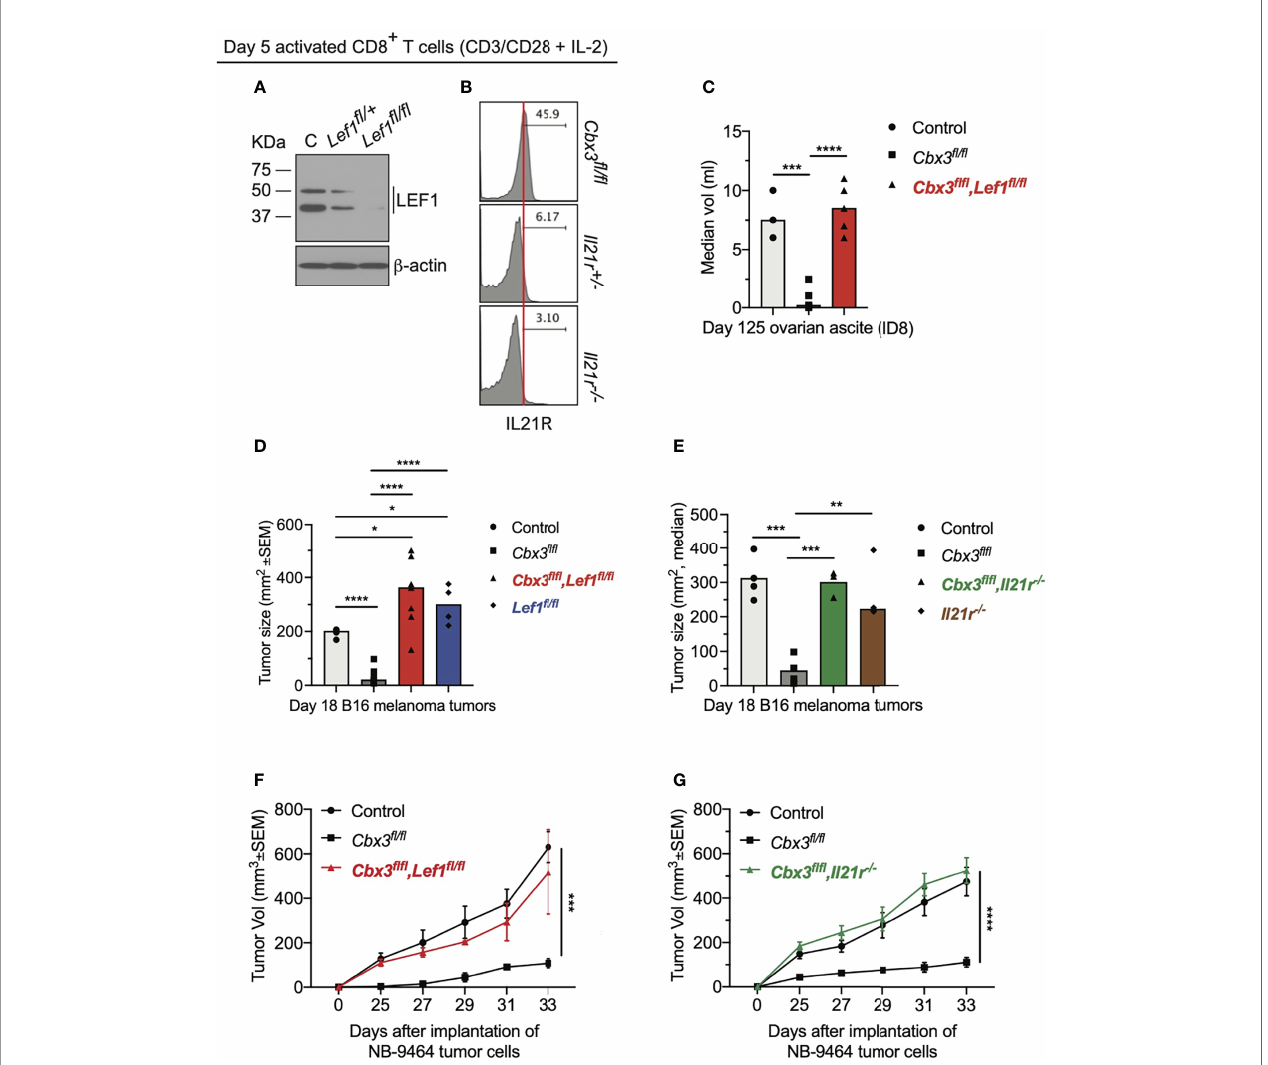
FIGURE 5 | LEF-1 and IL-21R are indispensable for halting tumor growth. (A) Western blot of LEF-1 expression was done using total protein lysates of day 5 activated/ differentiated CD8 + T cells; C: Cbx3 /HP1 g -de fi cient; Lef1 fl /+ and Lef1 fl / fl : Cbx3 - Lef1 -de fi cient; representative of 4 experiments. (B) IL-21R expression was measured by fl ow; Cbx3 fl / fl : Cbx3 /HP1 g -de fi cient; Il21r +/- and Il21r -/- : Cbx3 - Il21r -de fi cient; representative of 4 experiments. (C) Ovarian ascites were measured on day 125 after tumor injection; bars: group median; Graphpad unpaired student t-test: ***p ≤ 0.001, ****p ≤ 0.0001; each symbol = one mouse; n = 3-5; Cbx3 fl / fl Lef1 fl / fl : Cbx3 - Lef1 -de fi cient; representative of 2 experiments. (D) B16 melanoma tumor burden was determined on day 18 after tumor injection; bars: group median; Graphpad unpaired student t-test: *p ≤ 0.05, ****p ≤ 0.0001; each symbol = mouse; for each genotype n = 4-7; Lef1 fl / fl : Lef1 ablation alone using CD8 a -Cre mice; representative of 3 experiments. (E) On day 10 after injection of tumor cells, tumor bearing B6SJ/L mice (CD45.1 + ) were treated with in vitro -activated/differentiated CD8 + T cells (CD45.2 + ) from control, Cbx3 fl / fl , Cbx3 fl / fl , Il21r -/- ( Cbx3 - Il21r -de fi cient) or Il-21r -/- (germline deleted) mice; **p ≤ 0.01, ***p ≤ 0.001; n = 3-4 recipients; representative of 2 experiments. (F) NBL tumor burden was determined starting on day 25 after injection of tumor cells then every 2 days until day 33; Graphpad two-way ANOVA: ***p ≤ 0.001; n = 2-5; representative of 2 experiments. (G) On day 14 after NBL injection, tumor bearing B6SJ/L mice were treated with in vitro -activated/differentiated CD8 + T cells from control, Cbx3 fl / fl or Cbx3 fl / fl , Il21r -/- ( Cbx3 - Il21r - de fi cient) mice; ****p ≤ 0.0001, n = 3-4 recipients; representative of 2